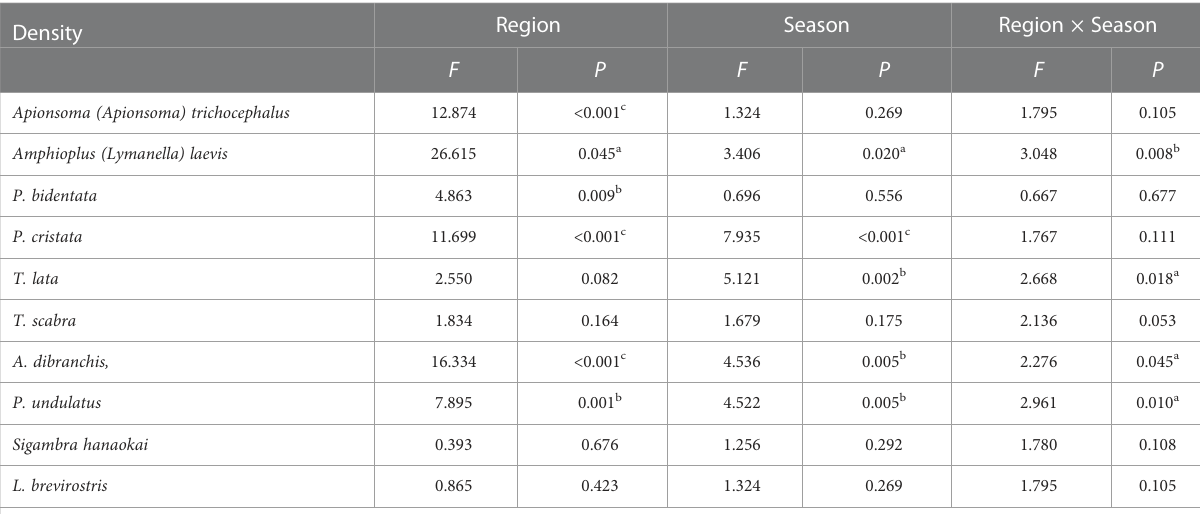
TABLE 1 The F and P values between seasons and regions for density of ten benthic macrofauna species in subtidal zone near the Daya Bay Nuclear Power Plant.